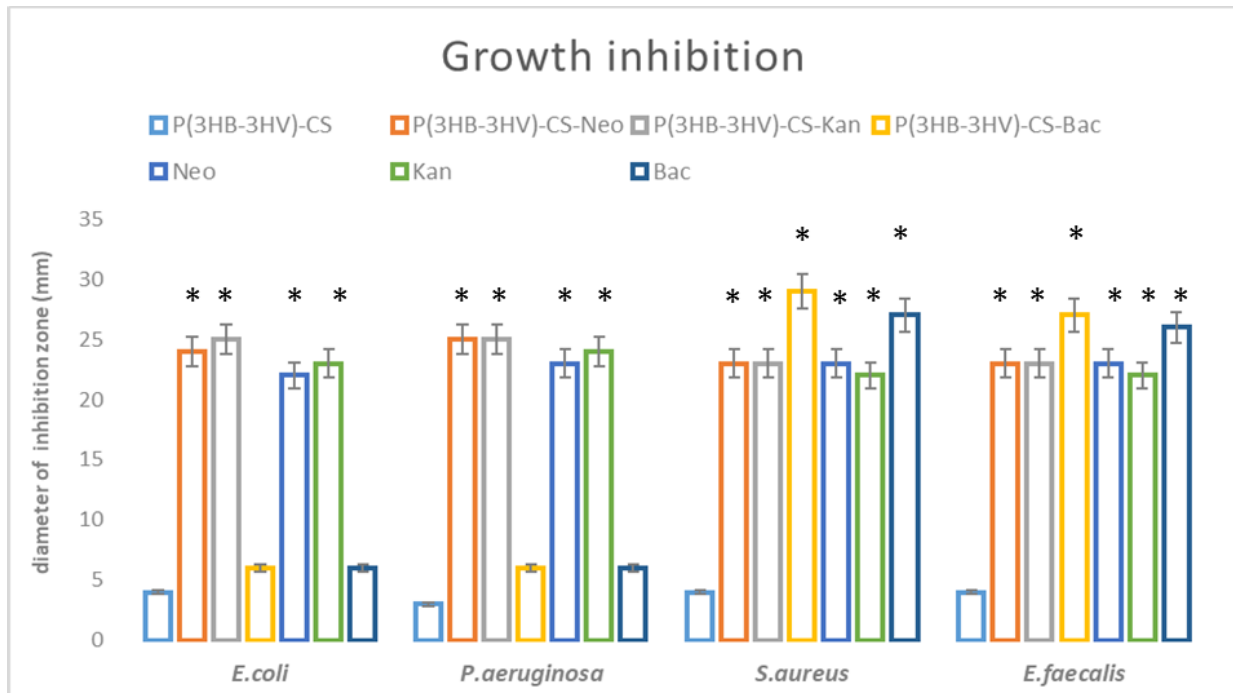
Figure 3. Graphic representation of antimicrobial potential of the obtained spheres, represented as diameter of inhibition zone evaluated for E. coli , E. faecalis , P. aeruginosa and S. aureus after 20 h incubation. * p < 0.05 (control sample = P(3HB- 3HV)-CS was compared to antibiotic containing samples).